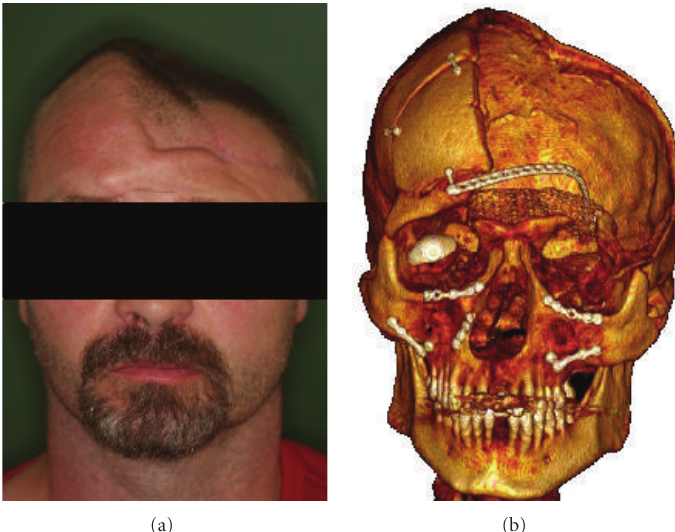
Figure 1: (a) Shows on the left an obvious skull deformity after crush injury. Bone is largely missing and the left orbital margin is severely compromised. The right eye is removed. (b) A composite 3D reconstruction of the patient’s skull showing the extensive bone loss and sequelae of multiple skull and facial fractures.